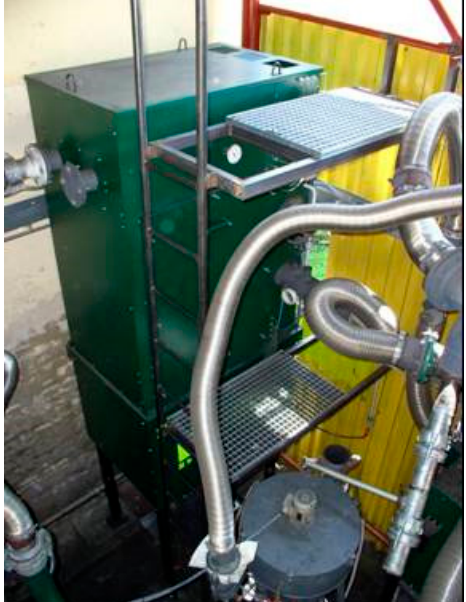
Figure 2. Sleeve filter for trapping solid particles (SP).